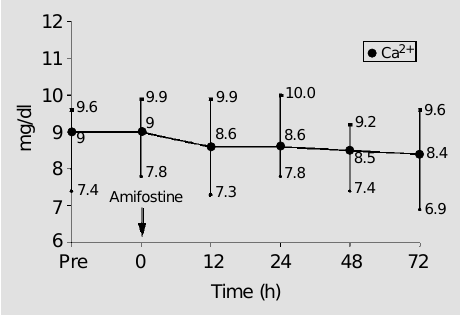
Figure 2 - Serum calcemia fol- lowing amifostine